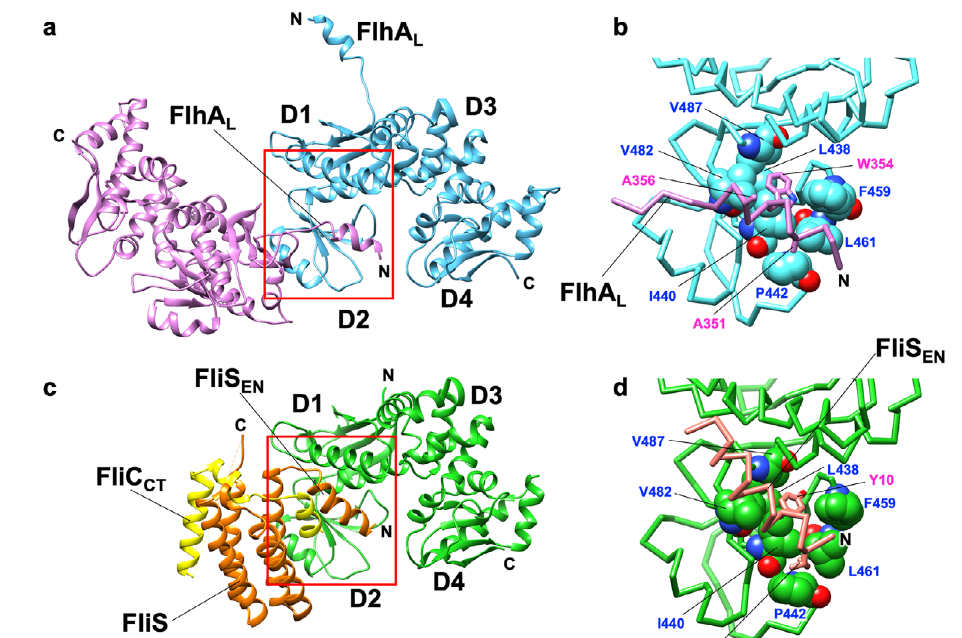
Fig. 6 Interaction between FlhA L and a well-conserved hydrophobic dimple of its neighboring FlhA C in the crystal of FlhA C-ED . a FlhA L of Mol-A (magenta) interacts with neighboring Mol-A (cyan) related by a crystallographic symmetry. b Close-up view of the interaction between FlhA L and the hydrophobic dimple shown by a red box in a . Residues that form the hydrophobic dimple are indicated by balls. The side chains of Ala-351, Trp-354, and Ala-356 in FlhA L are shown in stick models. c Interaction between FlhA C (green) and FliS (orange) fused with the C-terminal region of FliC (yellow) (PDB code: 6CH3). d Close-up view of the interaction between the extreme N-terminal region of FliS (FliS EN ) and the hydrophobic dimple shown by a red box in c . The residues that form the hydrophobic dimple are indicated by ball. The side chains of Ile-7 and Tyr-10 of FliS EN are shown in stick